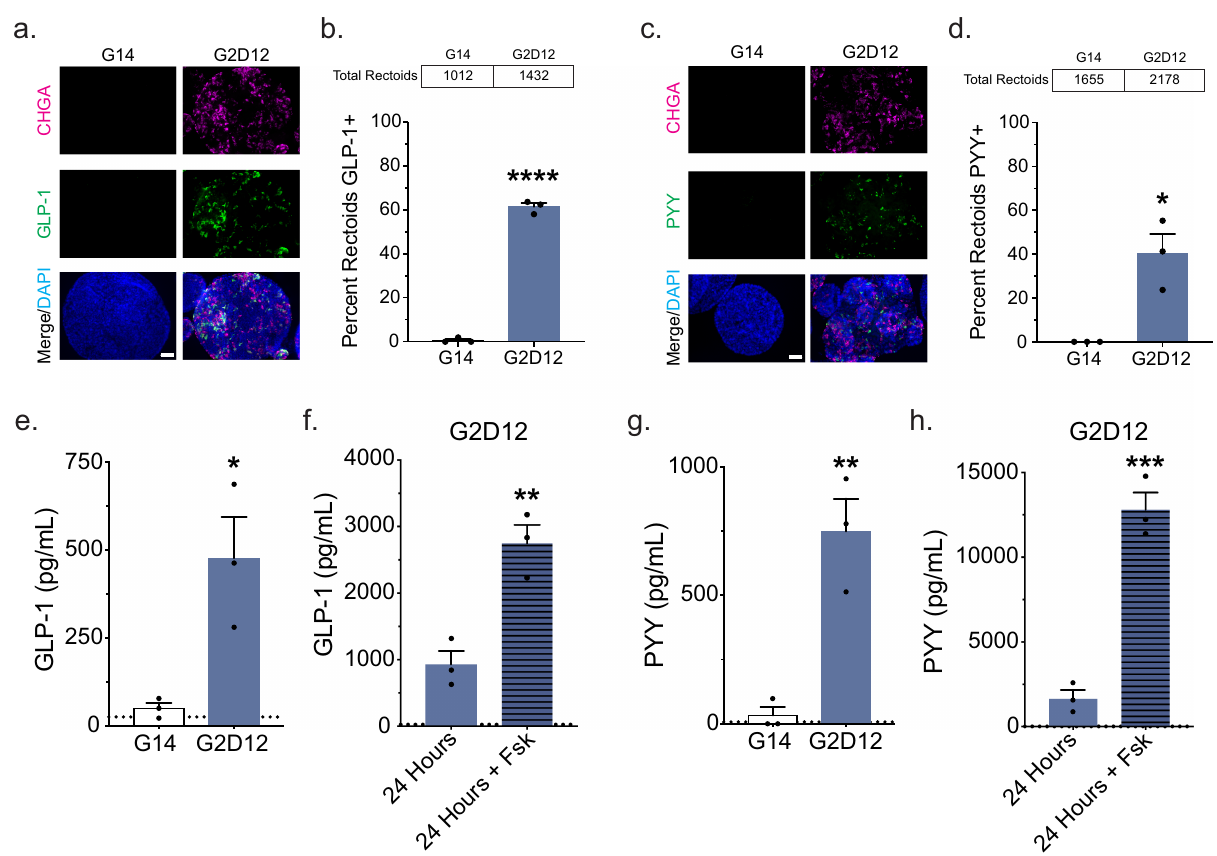
Fig. 9 Hormone production and secretion in rectoids. a Representative immuno fl uorescence staining of glucagon-like peptide-1 (GLP-1, green) and CHGA (magenta) in rectoids treated with G14 and G2D12. DNA (4 ′ ,6-diamidino-2-phenylindole (DAPI), blue). Scale bar = 50 µ m. b Percentage of rectoids with GLP-1 staining in G14 and G2D12. Average results are from three different rectoid lines or passages. **** p < 0.0001. c Representative immuno fl uorescence staining of peptide YY (PYY, green) and CHGA (magenta) in rectoids treated with G14 and G2D12. DNA (DAPI, blue). Scale bar = 50 µ m. d Percentage of rectoids with PYY staining in G14 and G2D12. Average results are from three different rectoid lines or passages. * p = 0.0118. e GLP-1 ELISA of conditioned media from the last two days of differentiation of rectoids grown in G14 and G2D12. Representative experiment showing n = 3 wells from each condition from a single rectoid line. * p = 0.0229. f GLP-1 ELISA of G2D12 conditioned media collected after 24 h on day 13 (solid bar) and after 24 hours with forskolin (Fsk) on day 14 (striped bar). Representative experiment showing n = 3 wells from each condition from a single rectoid line. ** p = 0.0061. g PYY ELISA of conditioned media from the last two days of differentiation of rectoids grown in G14 and G2D12. Representative experiment showing n = 3 wells from each condition from a single rectoid line. ** p = 0.0056. h PYY ELISA of G2D12 conditioned media collected after 24 h on day 13 (solid bar) and after 24 hours with forskolin (Fsk) on day 14 (striped bar). Representative experiment showing n = 3 wells from each condition from a single rectoid line. *** p = 0.0006. Bars show mean ± SEM; two-tailed unpaired t test ( b , d , e , f , g , h ). Dotted line at 25 pg/mL represents the lower limit of detection for the GLP-1 ELISA ( e , f ). Dotted line at 7.3 pg/mL represents the lower limit of detection for the PYY ELISA ( g , h ). Each experiment repeated with at least three different rectoid lines. Tables above graphs show the total number of rectoids examined per condition. Source data are provided as a Source Data fi